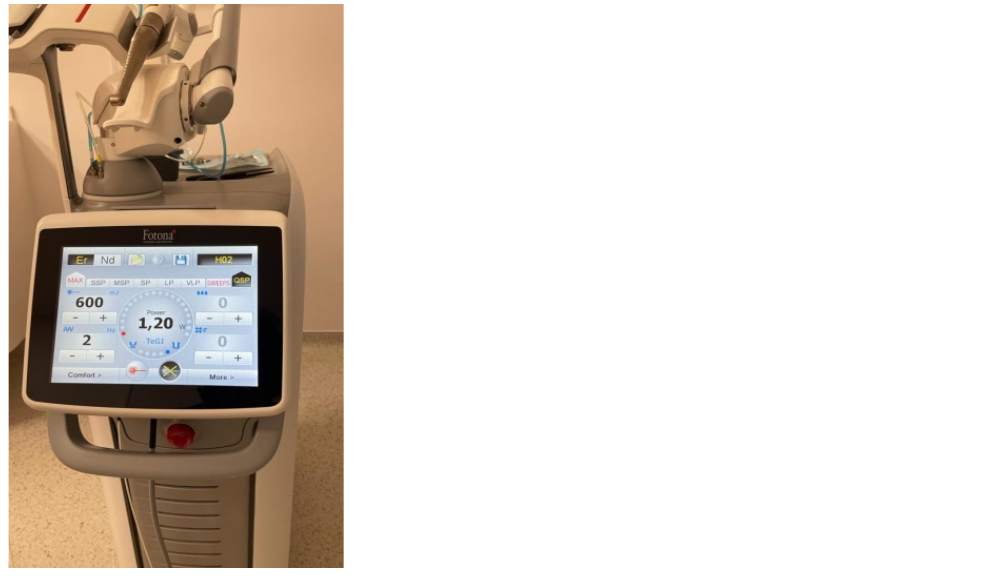
Figure 2. Wong–Baker FACES Pain Rating Scale based on facial appearance relative to pain levels